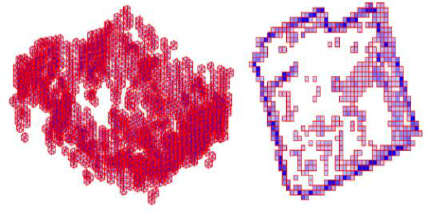
Figure 8. Environment differential model from to different view.